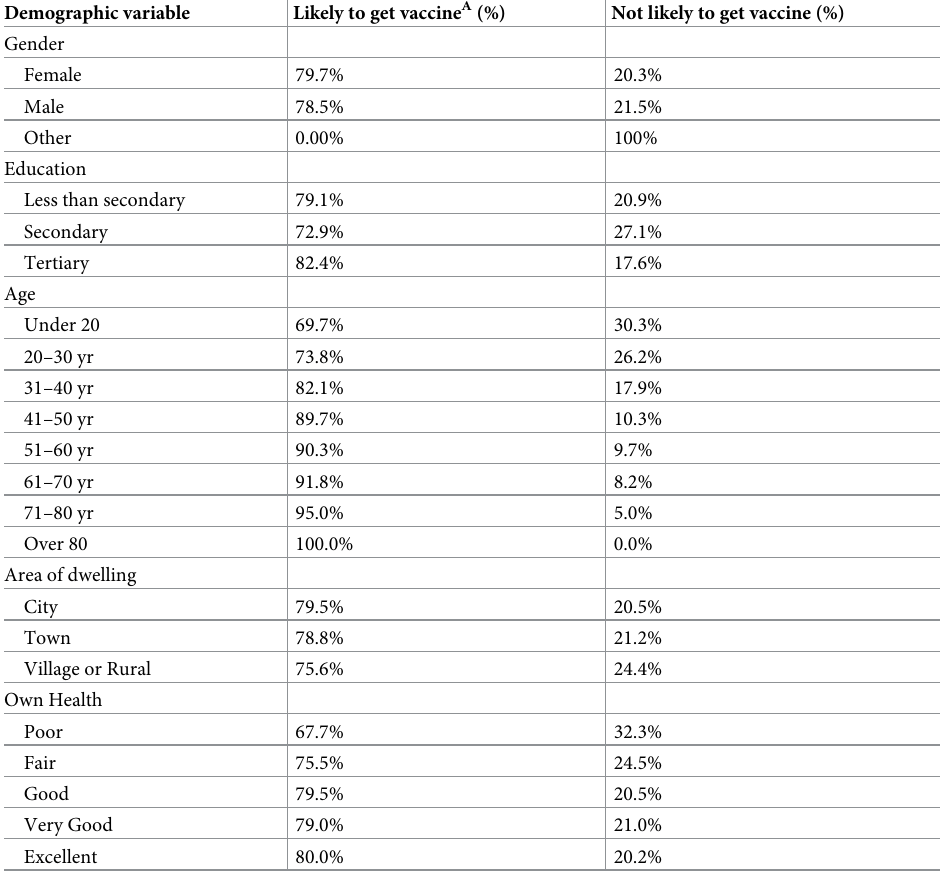
Table 2. Demographic characteristics vaccination intention (n =